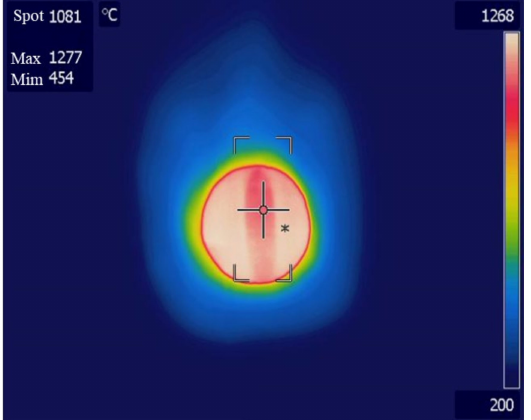
Figure 11. Reactor 2 surface temperature measured by thermal imaging camera.